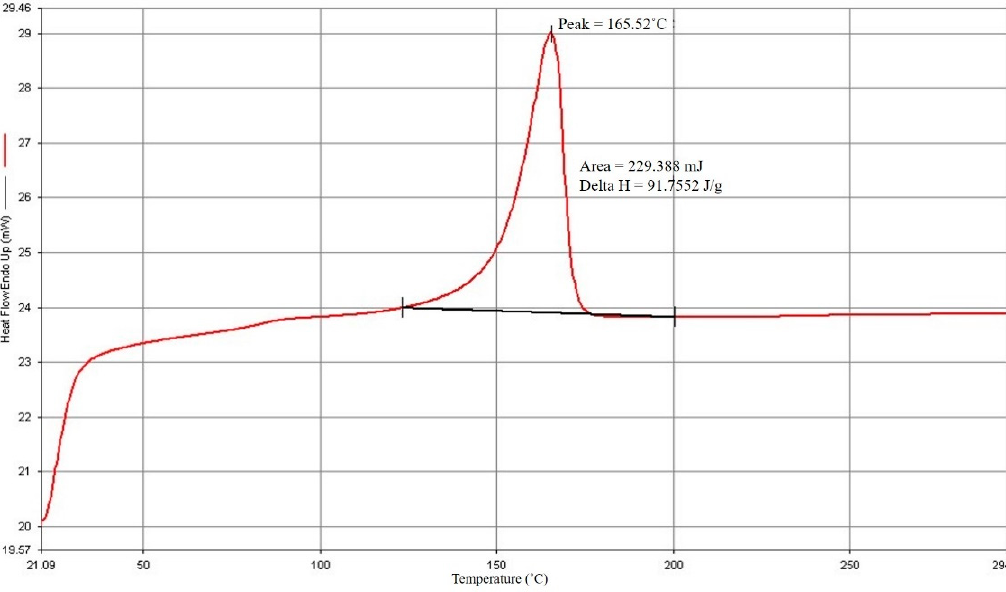
Figure 2. PP melting point.